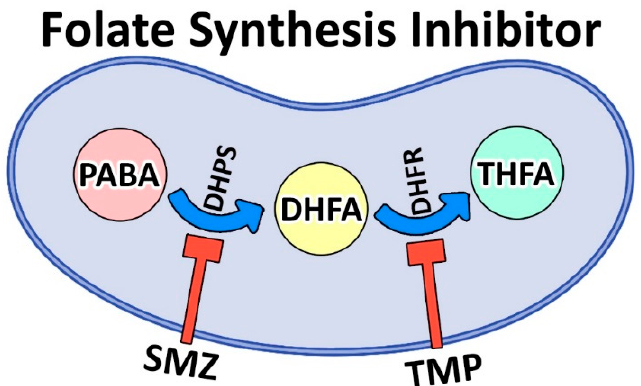
Figure 1. Biosynthesis pathway of folic acid from para-aminobenzoic acid (PABA) using nicotinamide adenine dinucleotide phosphate (NADPH) coenzyme. PABA, as a precursor, contributes to the synthesis of dihydrofolic acid (DHFA) and then tetrahydrofolic acid (THFA). THFA, in turn, gives rise to thymidine, purines, and methionine. TMP/SMZ inhibits folate synthesis by inhibiting dihydrofolate reductase (DHFR) and dihydropteroate synthetase (DHPS), respectively, as the two key enzymes of the folate pathway.